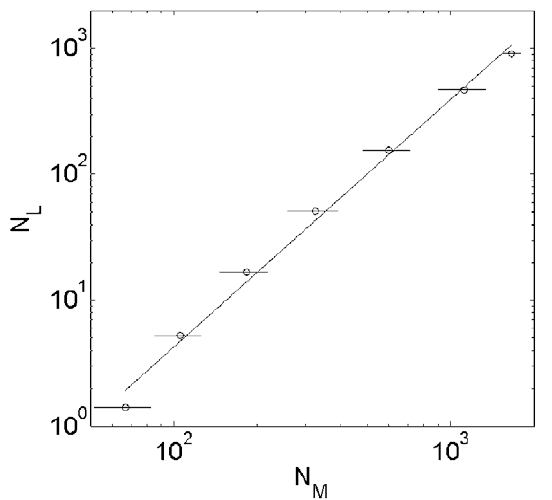
Figure 7. n byproduct vs. n M . Faster-than-linear scaling of the number of byproducts, n byproduct , and the total number of metabolites, n M , in individual branched pathways illustrated in Figure 4. Data for individual pathways were logarithmically binned along the x-axis. Hence y-axis can be and are below 1 due to pathways with 0 byproducts. The solid line with exponent 1.7 + / 2 0.1 is the best fit to the logarithmically- binned data shown in this plot. Readers can refer to the section ‘‘Analysis of number of by-product of the pathways of the toolbox model on the metabolic network with branched pathways and multi- substrates reactions’’ of Text S1 for our estimation methods and error analysis.